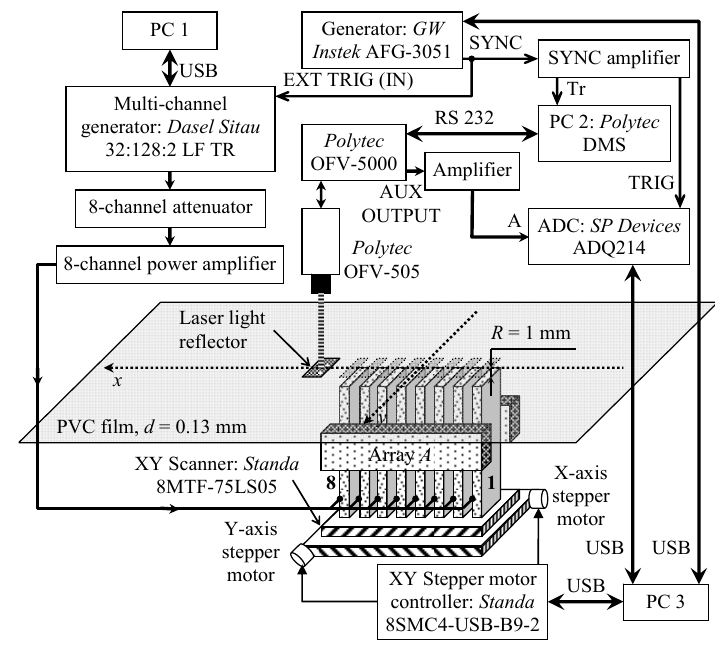
Figure 8. Experimental setup using a laser interferometer. The recorded B-scan is presented in Figure 10a. The A-scan signal was taken from the B-scan at a distance of 12.5 mm, as shown in Figure